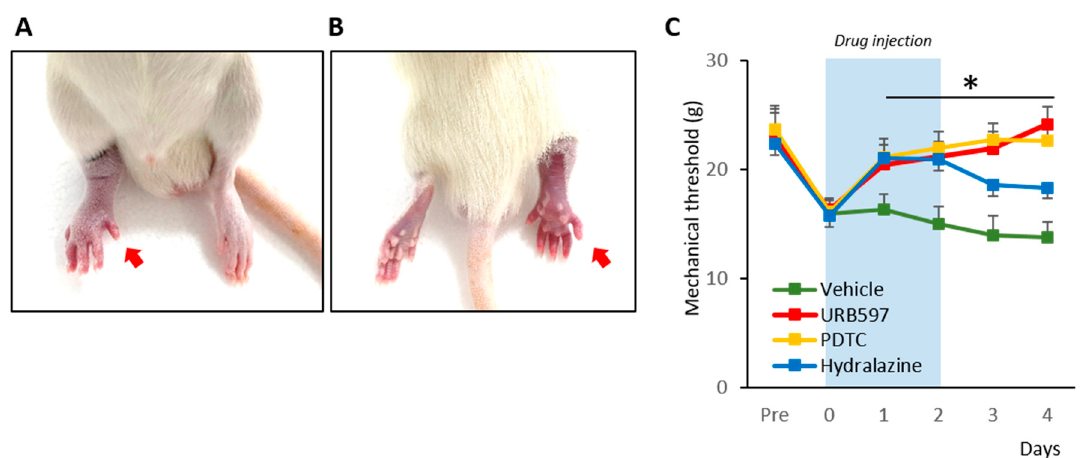
Figure 1. Rat model of chronic post-ischemia pain (CPIP) and nocifensive behavior changes. ( A ). Representative photographs of the rat hind paw taken during CPIP model establishment. The red arrow indicates the paw treated with an O-ring. ( B ). Hind-view of the paw with the O-ring. ( C ). Mechanical threshold changes pre- and post-CPIP. n = 6 rats/group; one-way ANOVA followed by Tukey post hoc test was used for statistical analysis; * p < 0.05.